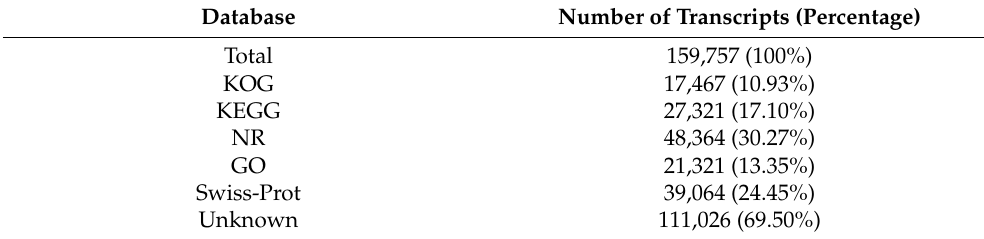
Table 4. Result of